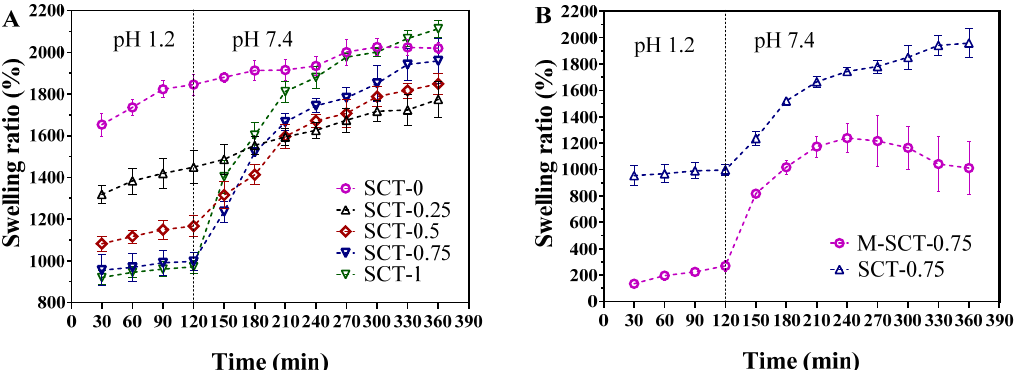
Figure 2. The addition of STPP and multilayer SA matrix can reduce the swelling rate of hydrogel. ( A ) Swelling behavior of SCTs’ hydrogels with different STPP amounts in SGF (pH 1.2) and SIF (pH 7.4). ( B ) Swelling characteristics of SCT-0.75 hydrogels and M-SCT-0.75 hydrogels in SGF (pH 1.2)